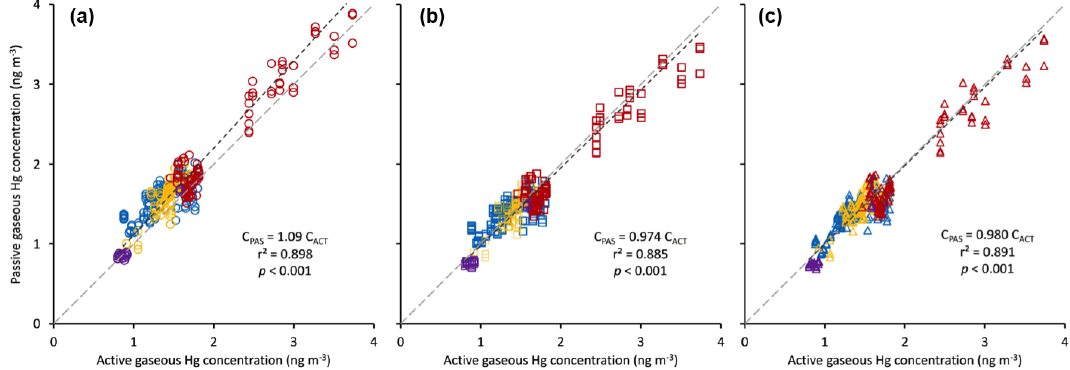
Figure 3. Comparison of active ( C ACT ; x axis) and passive ( C PAS ; y axis) gaseous Hg concentrations derived from the original sampling rate (SR; circles in a ), recalibrated SR (squares in b ), and adjusted SR (triangles in c ). Dotted lines represent the trend line for each dataset. Grey dashed line is the 1 : 1 relationship. Markers are coloured according to site type: red – urban sites; blue – rural sites; purple – high-altitude sites; and yellow – northern/Arctic sites. Fitted relationships are for all data